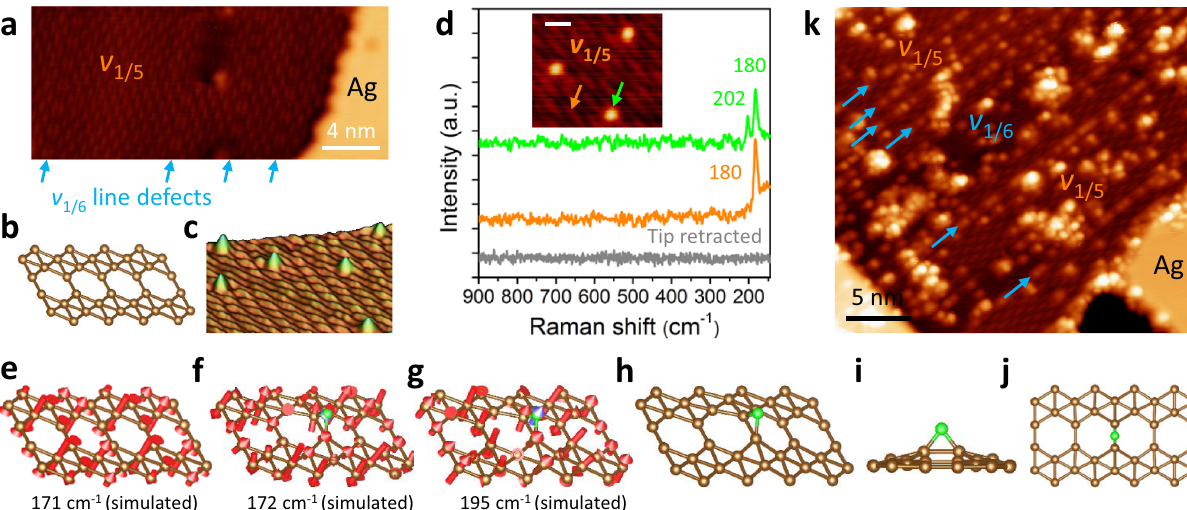
Fig. 4 Oxidation of v 1/5 borophene with atomic and molecular oxygen. a STM image of pristine v 1/5 borophene showing the presence of v 1/6 line defects as indicated by the blue arrows. b Oblique view of the atomic structure of v 1/5 borophene. c Three-dimensional rendered STM image of oxygen adatoms on v v 1/5 borophene following exposure to 6 L of atomic oxygen. d TERS of atomic oxygen adsorbed on 1/5 borophene. Inset: arrows mark the tip positions for TERS measurements; scale bar: 1 nm. e Atomic displacements of the B 2 Raman mode of pristine v 1/5 borophene. f , g Atomic displacements of Raman g modes of O-adsorbed v 1/5 borophene. Green spheres and blue arrows represent oxygen atoms and their displacements, respectively. h Oblique, i side, and j top views of the most energetically stable con fi guration of an oxygen adatom on v 1/5 borophene. k STM image of v 1/5 borophene after exposure to 4800 L of molecular oxygen. A small v 1/6 domain and v 1/6 line defects indicated by blue arrows are present. TERS measurement parameters: 0.1 V, 3 nA, 5 s. Scanning conditions: a 1.0 V, 2.0 nA; c − 0.2 V, 700 pA; d − 0.2 V, 700 pA; k 0.8 V, 1.0